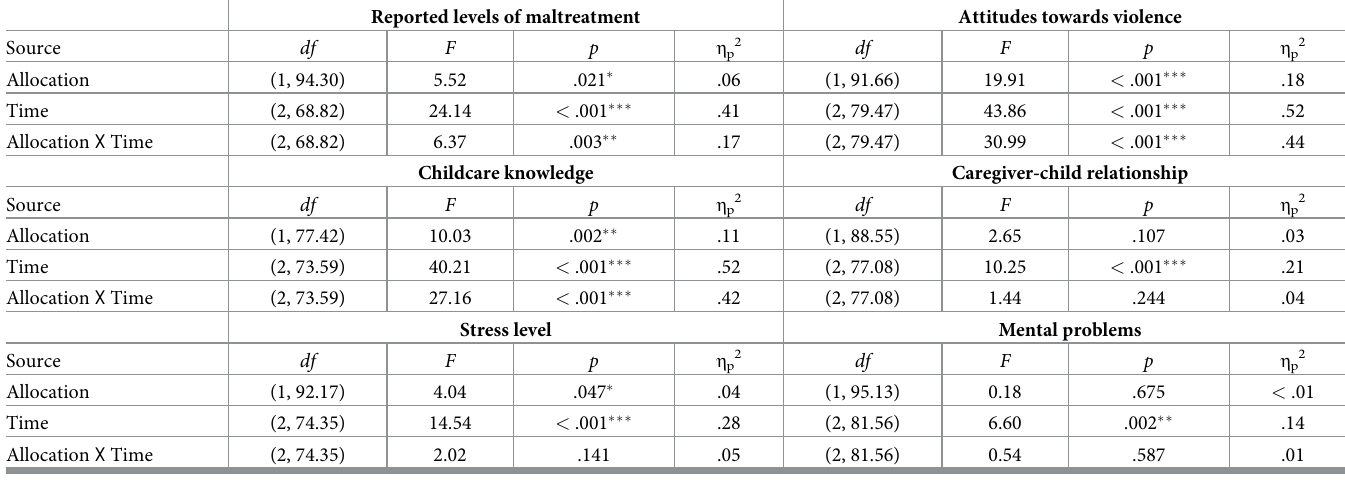
Table 2. Robust ANOVA summary table.